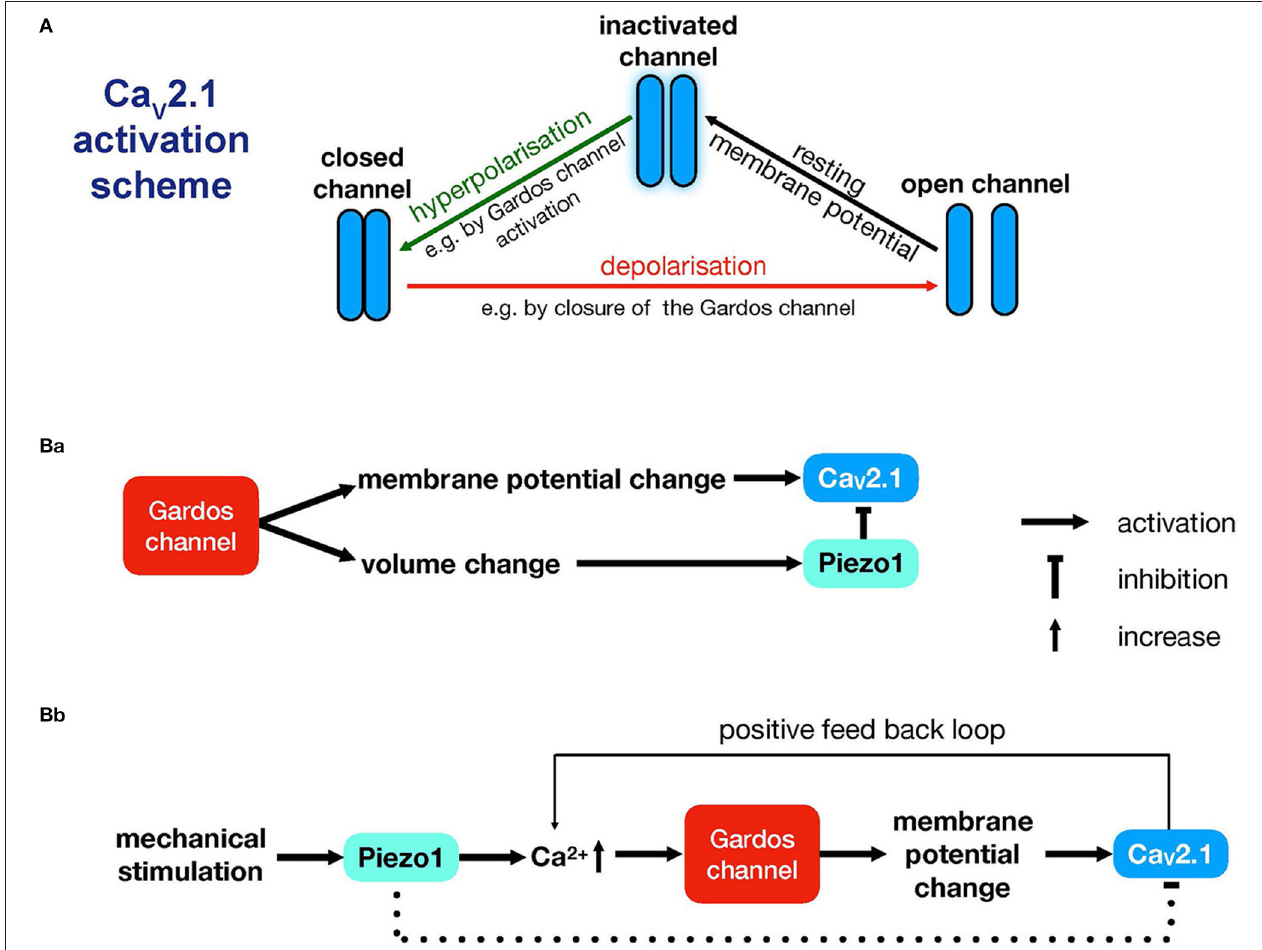
FIGURE 1 | Interplay between Ca V 2.1, Piezo1 and the Gardos channel. (A) Activation scheme for the Ca V 2.1 channel modulated by underlying Gardos channel activity. (B) Proposed interactions between Ca V 2.1, the Gardos channel and Piezo1. (Ba) illustrates a mechanism that is compatible with the measurements presented in Wesseling et al. (2016) and that explains the pathophysiological events seen in Gardos channelopathy (Fermo et al., 2017). (Bb) illustrates a sequence of events that is more likely to be relevant to physiological mechanical stimulation conditions in the circulation ( Faucherre et al., 2013; Cahalan et al., 2015; Danielczok et al., 2017a ). Whether Piezo1 would exert an inhibitory effect in this scenario is an open question, and therefore, this is depicted with a dashed line. For more details, see the main